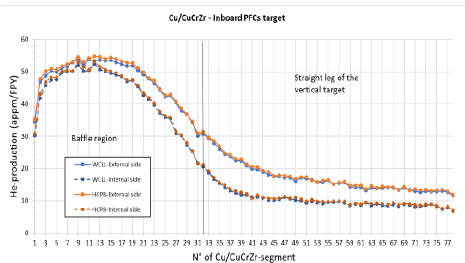
Figure 42. Inner poloidal profiles of the He-production (appm/FPY) on Cu/CuCrZr components, comparing the values on the external and the innermost target sides, both for WCLL and HCPB blanket case.